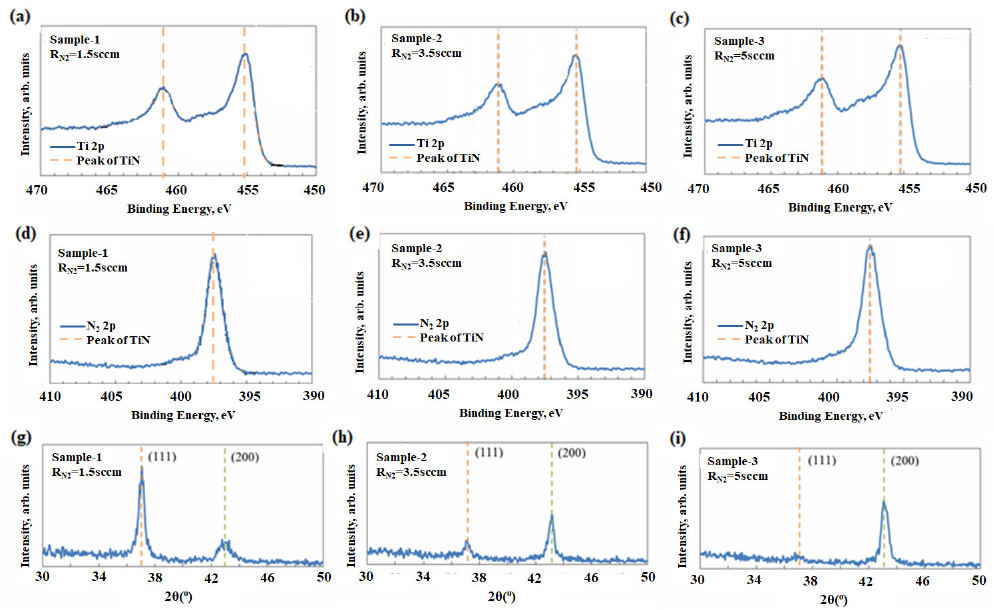
Figure 3. ( a – c ) Ti 2 p and ( d – f ) N 1 s photoemission core level spectra of TiN thin films; ( g – i ) X-ray diffraction by TiN thin films.